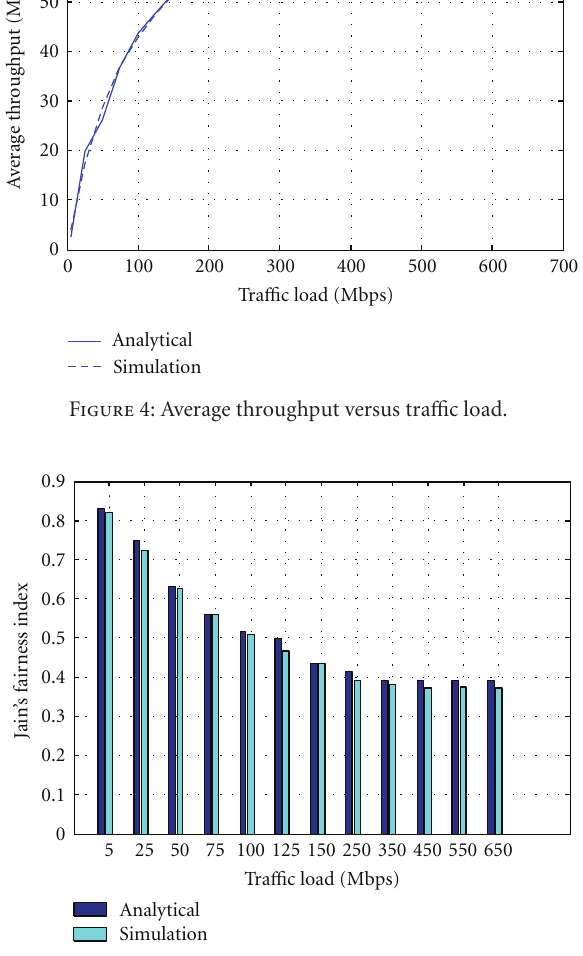
Figure 5: Jain’s fairness index versus tra ffi c